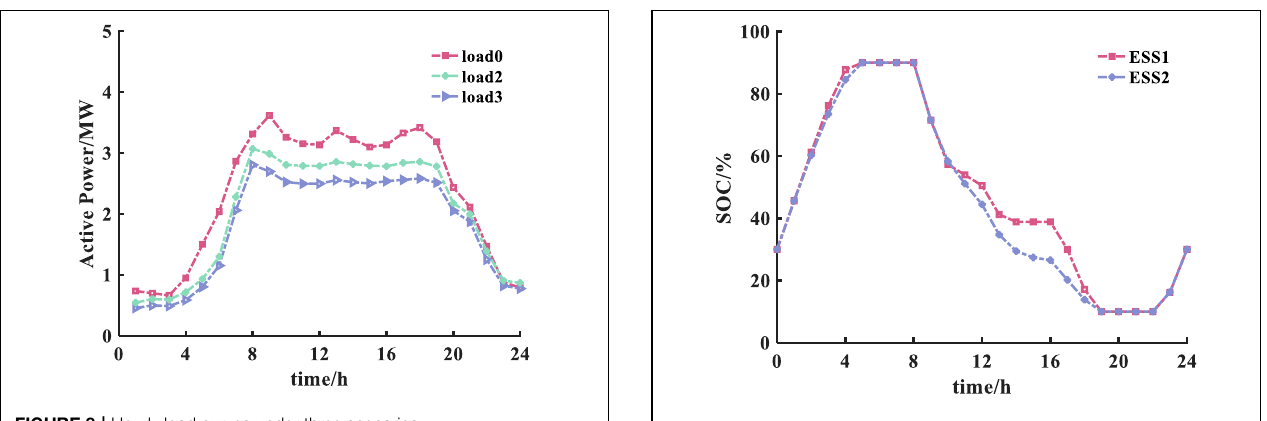
FIGURE 11 | Hourly SOC state of charge of ESS.